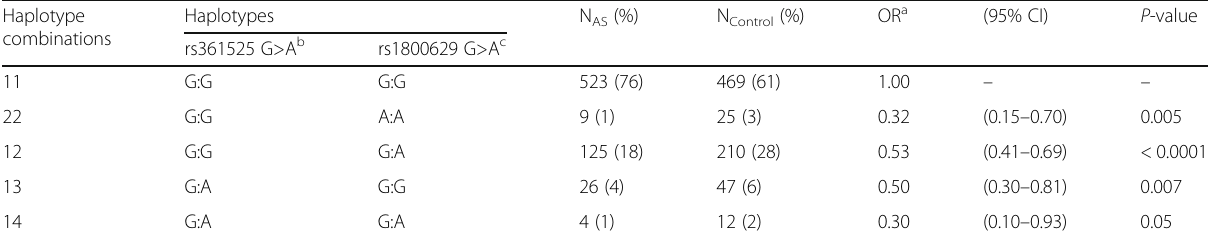
Table 6 Association of the TNF haplotype combinations and risk of ankylosing spondylitis (AS). The haplotype combinations in TNF described 97% of the genotypes observed Haplotype